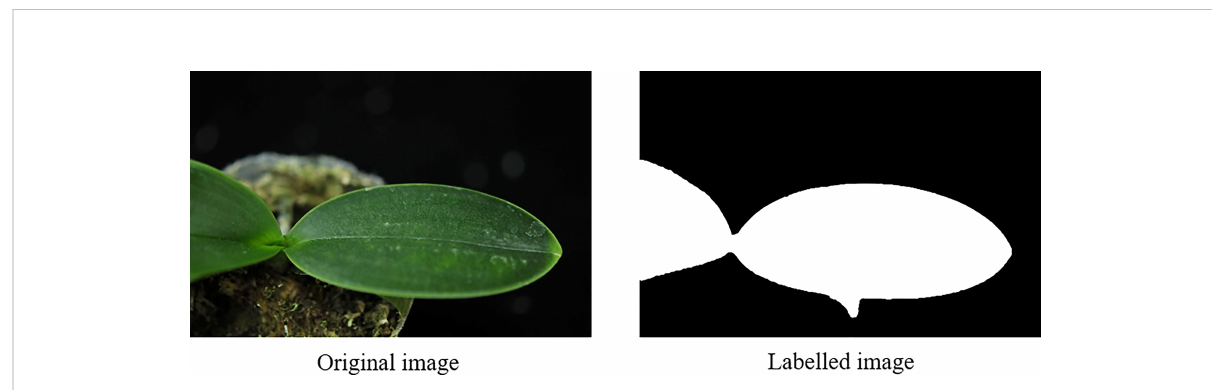
FIGURE 6 Manual labelling for the leaf region (white region) and background region (black